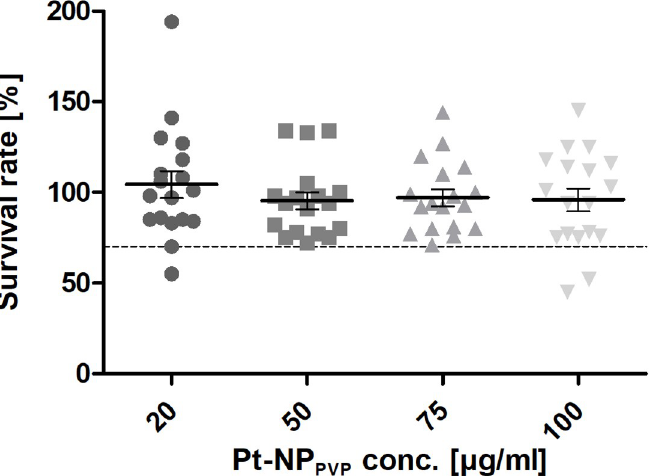
Fig 5. Determination of dose-dependent effects of Pt-NP PVP on the survival rate and neurite outgrowth of the SG neurons cultivated for 48 h. Determination of the impact of varying Pt-NP PVP concentrations on the survival rate (Fig 5) and neuritogenesis of the SG neurons characterized by anti-neurofilament 200 staining (Fig 6) cultivated for 48 h in cell culture medium containing 20 μ g/ml—100 μ g/ml Pt-NP PVP . Each data point is presented as mean and SEM of the (Fig 5) percentage of stained SG neuron soma in cell culture assays supplied with Pt-NP PVP (N = 6, n = 18 of each Pt- NP PVP concentration) in relation to the reference without Pt-NP PVP administration and (Fig 6) length of nerve fibres (N = 6, n = 90 neurons exposed to varying Pt-NP PVP concentration, respectively). One-way ANOVA with Tukey’s multiple comparison test was performed for statistical assessment. The dashed line in (Fig 5) represents the cytotoxicity limit (70%).